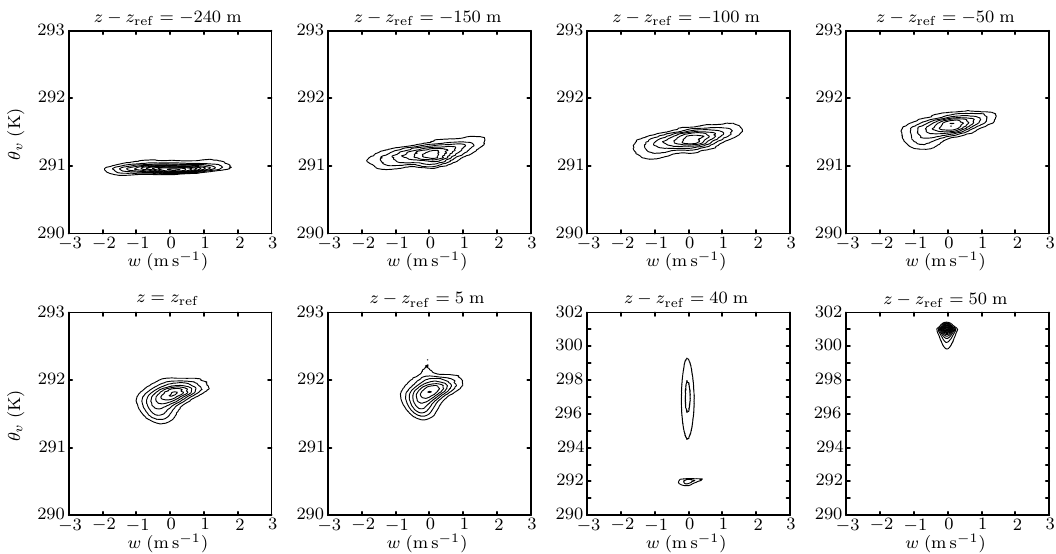
Figure 9. Joint probability density functions of virtual potential temperature and vertical velocity. Each panel corresponds to different height. The heights are with respect to the height of the maximum mean cloud liquid z ref . The contours are plotted in logarithmic